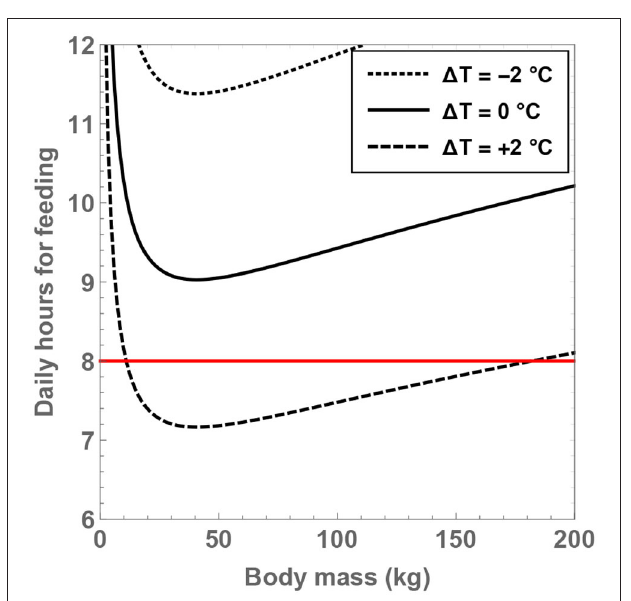
FIGURE 4 | Compatible values of the number of hours per day expended on feeding ( H ) and body mass ( M BD ) are determined for putative hominins endowed with 80 billion neurons; the regions lying above the curves depict the allowed values. The dotted, unbroken and dashed curves correspond to body temperatures that differ from present-day humans by − 2, 0, and + 2 ◦ C; the equivalent body temperatures are 35, 37, and 39 ◦ C, respectively. The horizontal red line represents H = 8 and can be regarded as a “sustainable” upper bound on H .